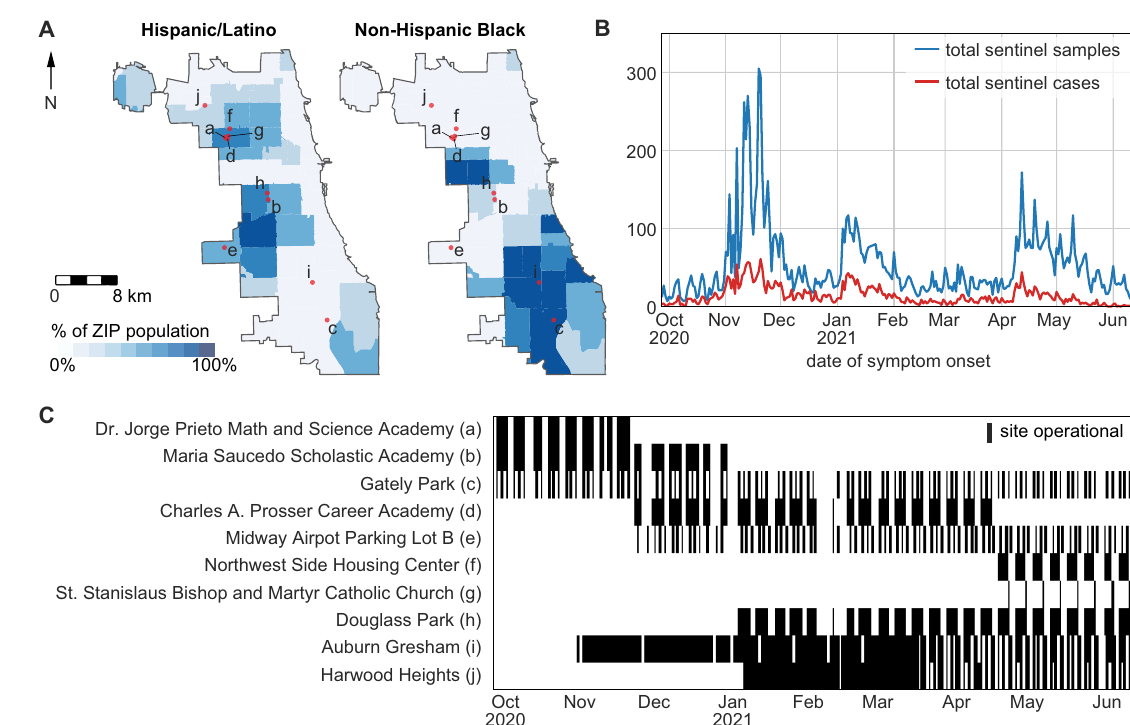
Hispanic Black (right map). B Total sentinel samples (blue, n =13,952) and sentinel cases (red, n =3607) plotted by date of symptom onset. C Operating dates (black bars) of static sentinel testing sites.